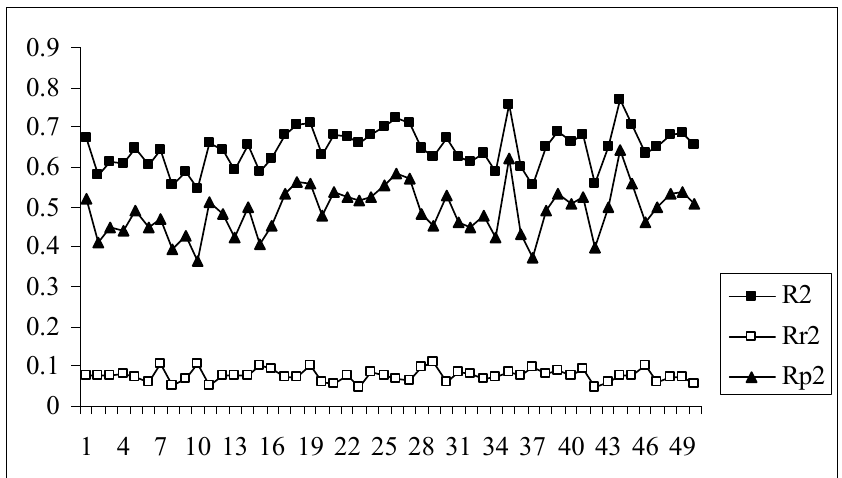
Figure 8. Comparative plots of R 2 , R r2 and R p2 values of 50 models (data set